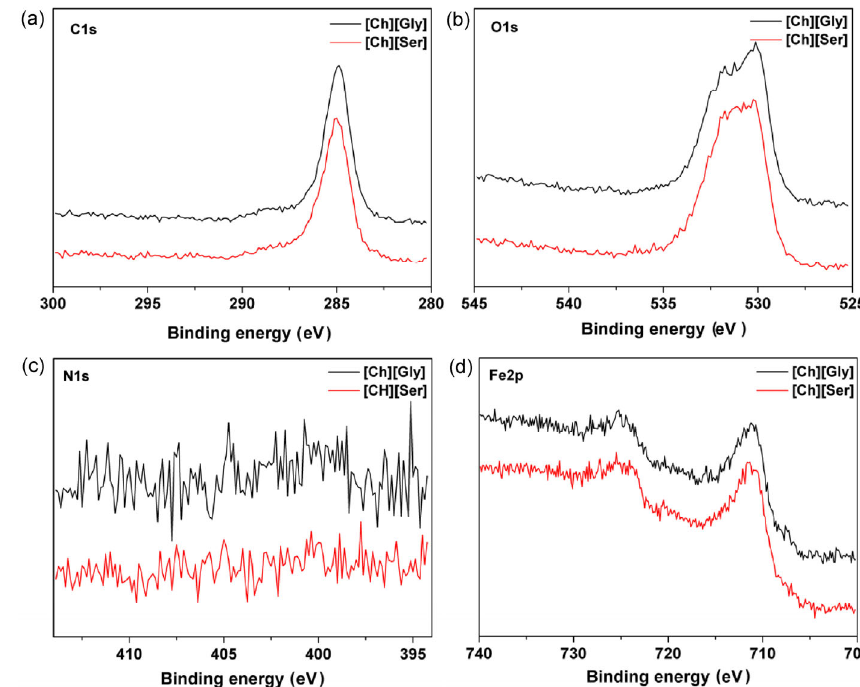
Fig. 9 C1s, O1s, N1s, and Fe2p XPS region scans for wear scars with [Ch][Gly] and [Ch][Ser]